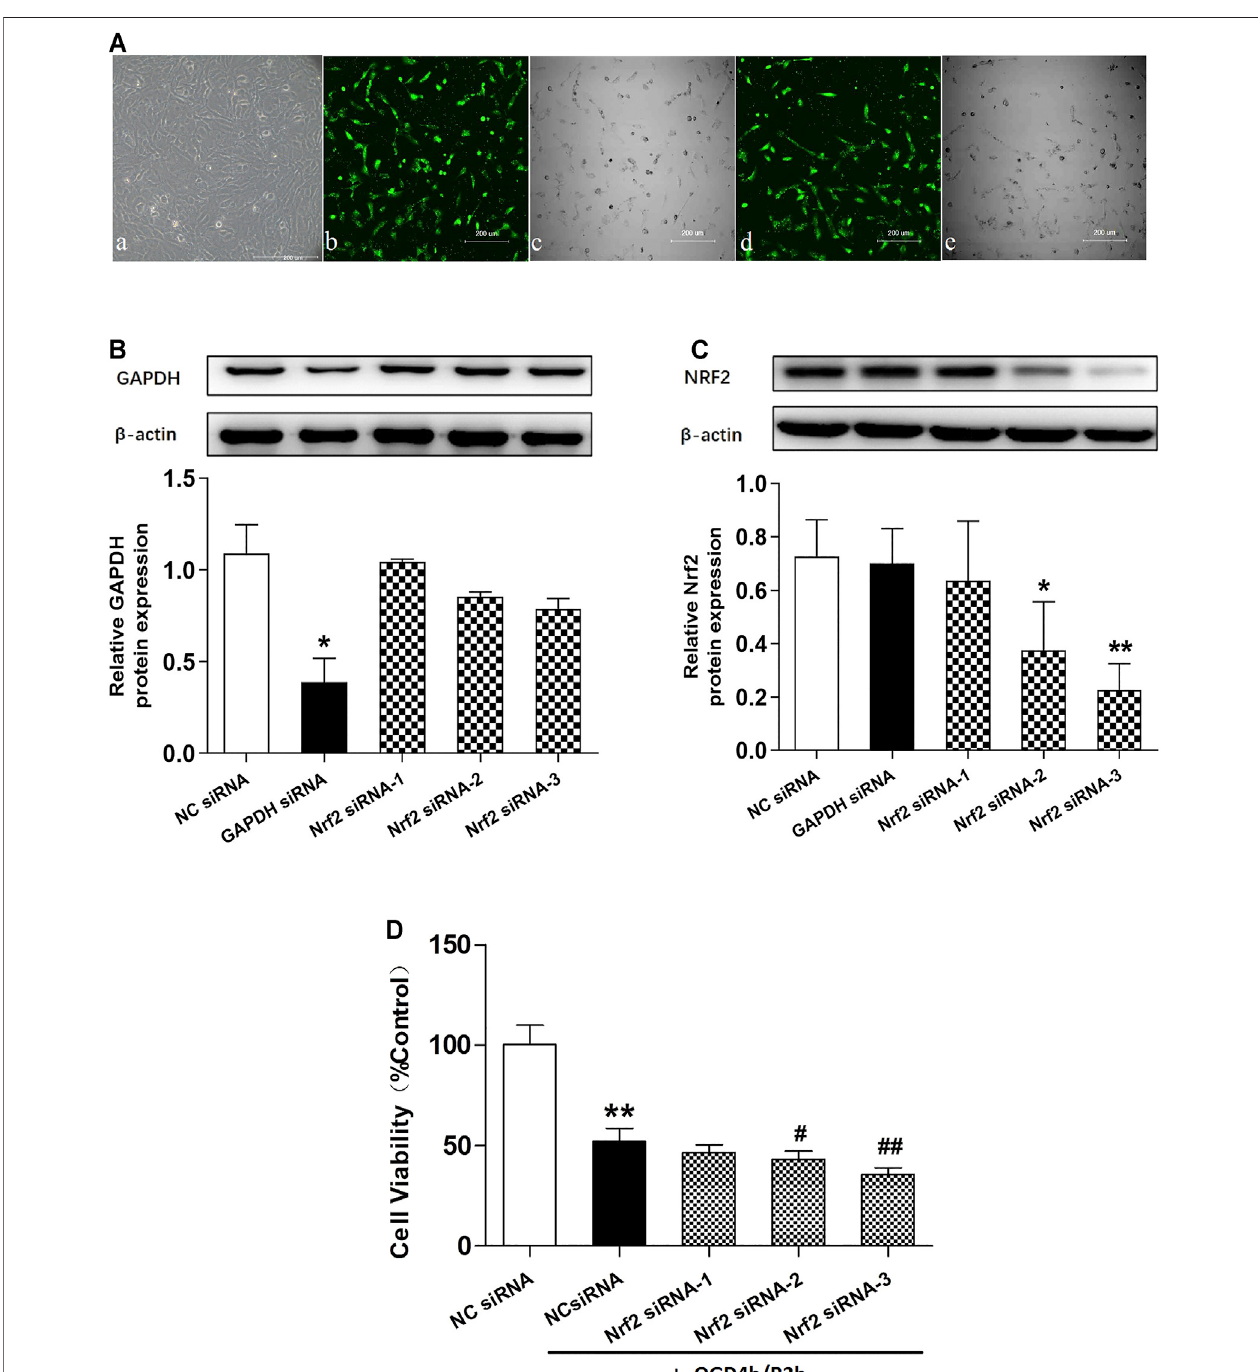
FIGURE6| Effects ofdifferentNrf2siRNAinterferencesonNrf2expressions and hCMEC/D3 cellviabilitiesinOGD/R. (A) (a) hCMEC/D3cellsundernormalculture condition. (b,c,d,e) Different concentrations of the negative control siRNA labeled with green fl uorescence were applied to hCMEC/D3 cells to help optimize the transfection conditions. (b,c) Fluorescence and bright fi eld images of hCMEC/D3 cells treated with 50 nmol/L plasmid. (d,e) Fluorescence and bright fi eld images of hCMEC/D3 cells treated with 100 nmol/L plasmid. Plasmids of the two concentrations showed similar transfection ef fi ciency, while the lower one showed less cell loss; thus, 50 nmol/L was selected as the optimal concentration for transfection and was used in the subsequent experiments. (B,C) Western blot assays for expressions of GAPDH and Nrf2 in hCMEC/D3 cells. The cells were transfected with GAPDH siRNA plasmid or Nrf2 siRNA plasmid (Nrf2 siRNA-1, Nrf2 siRNA-2, and Nrf2 siRNA-3); the results showed the expressions of target genes were speci fi cally knocked down by aiming siRNAs, testifying speci fi cities and ef fi ciencies of the siRNAs. Besides, Nrf2 siRNA-3 showed the strongest ability to interfere with the expression of Nrf2. (D) Effects of different Nrf2 siRNAs on OGD/R injury of hCMEC/D3 cells. Data are expressed as mean ± SD ( n (cid:1) 3). * p < 0.05, ** p < 0.01 vs. negative control siRNA (NC siRNA); # p < 0.05, ## p < 0.01 vs. NC siRNA +